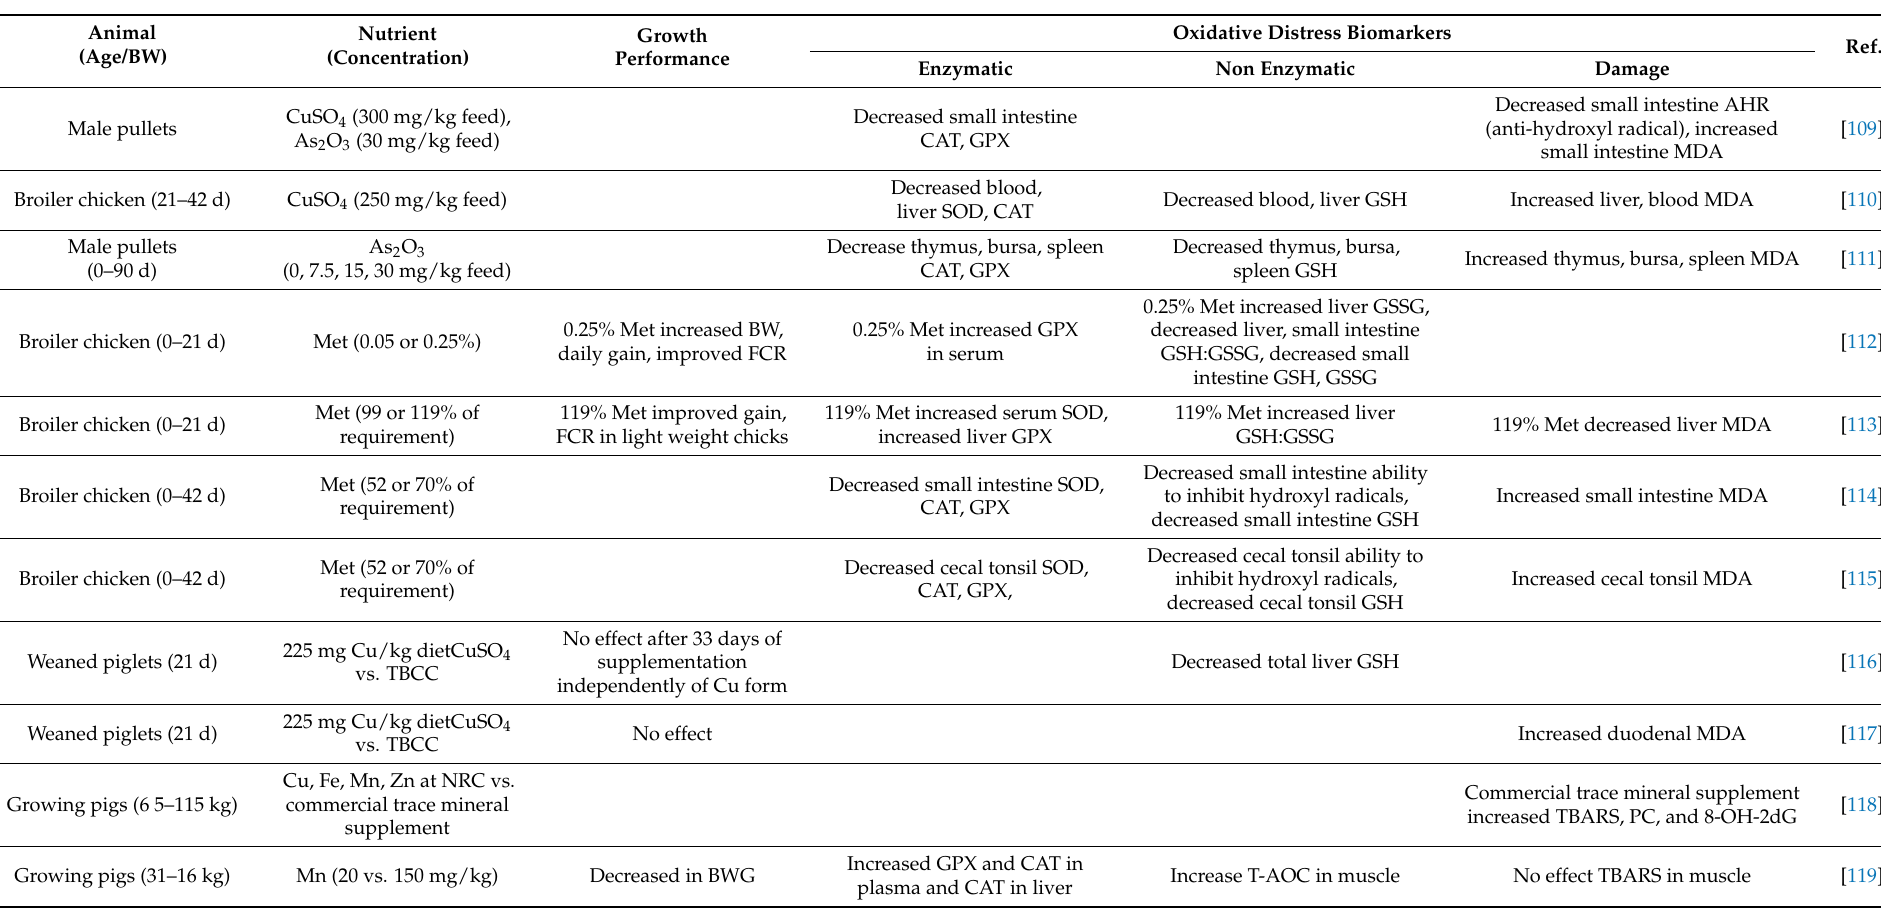
Table 4. Summary of the dietary oxidative challenge models using minerals imbalances in poultry and swine diets, including nutrient level, and results, including effect on growth performance and markers of oxidative distress classified as enzymatic, non-enzymatic, or